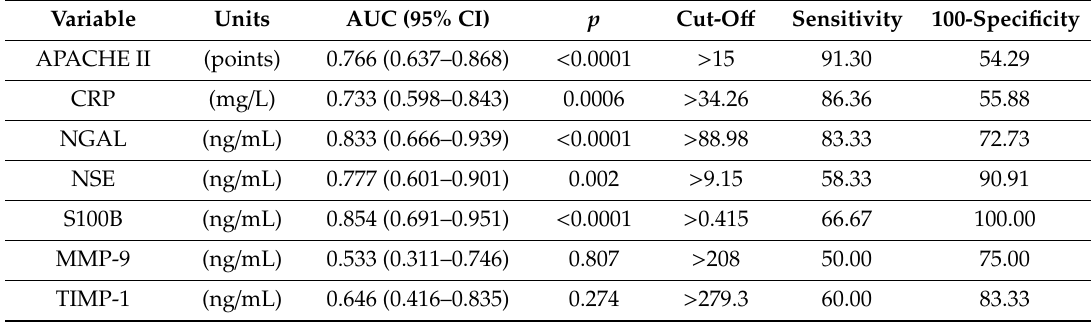
Table 4. ROC curve analysis for mortality prediction by the investigated biomarkers 1 .